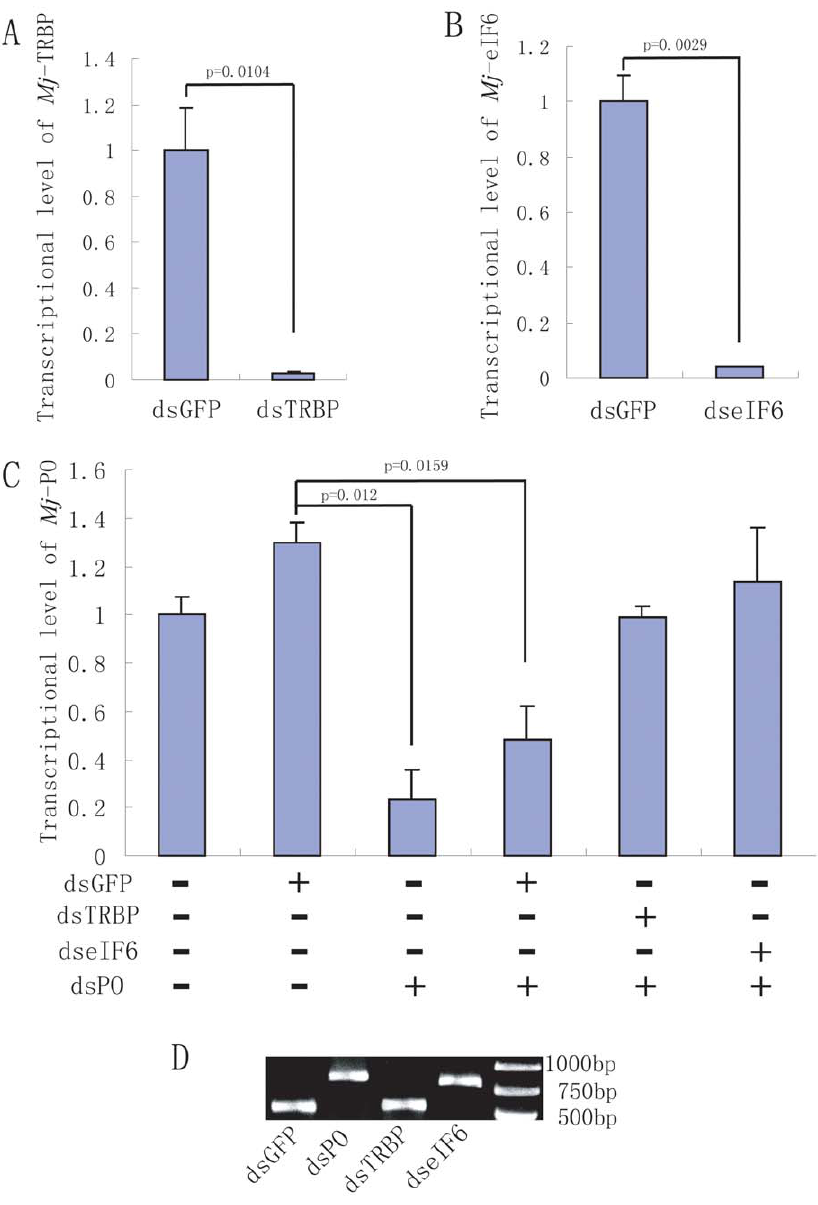
Figure 6. M j-TRBP and Mj -eIF6 were involved in dsRNA-induced silencing. A, B; Injection of Mj -TRBP dsRNA (dsTRBP) or Mj -eIF6 dsRNA (dseIF6) could significantly knock down Mj -TRBP or Mj -eIF6, respectively. C: Silencing of Mj -TRBP and Mj -eIF6 impaired the activity of the RNAi pathway. Injection of Mj -PO dsRNA (dsPO) could silence Mj -PO, whereas, the mRNA level of Mj -PO still remained high when the shrimp were injected with dsTRBP and dseIF6, but not dsGFP, indicating the activity of the RNAi pathway was impaired by knocking down Mj -TRBP or Mj -eIF6. GFP dsRNA was used as a control. D: Agarose gel electrophoresis show the same amount of dsRNA was injected into the shrimp.